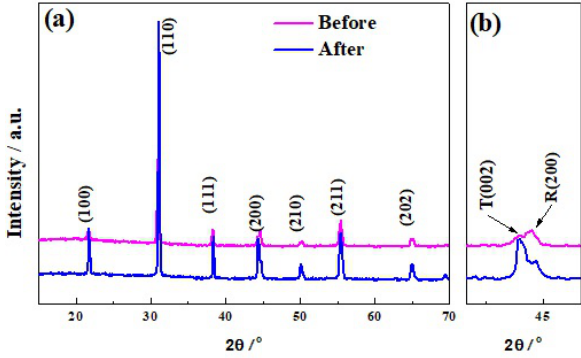
detail analysis of the (200) and (002) peaks, it can be seen that after electric degradation, the content of tetragonal phases T(002) increases significantly, which is attributed to that under the action of applied voltage for a long